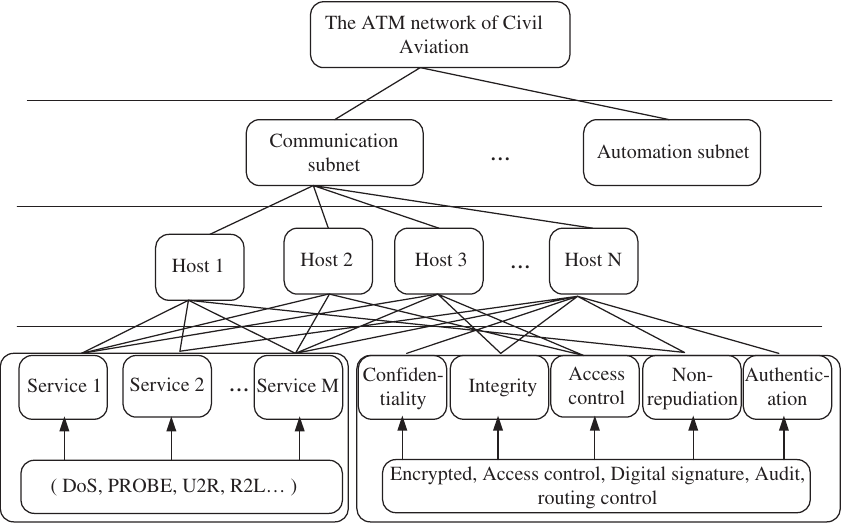
Figure 5. Experimental